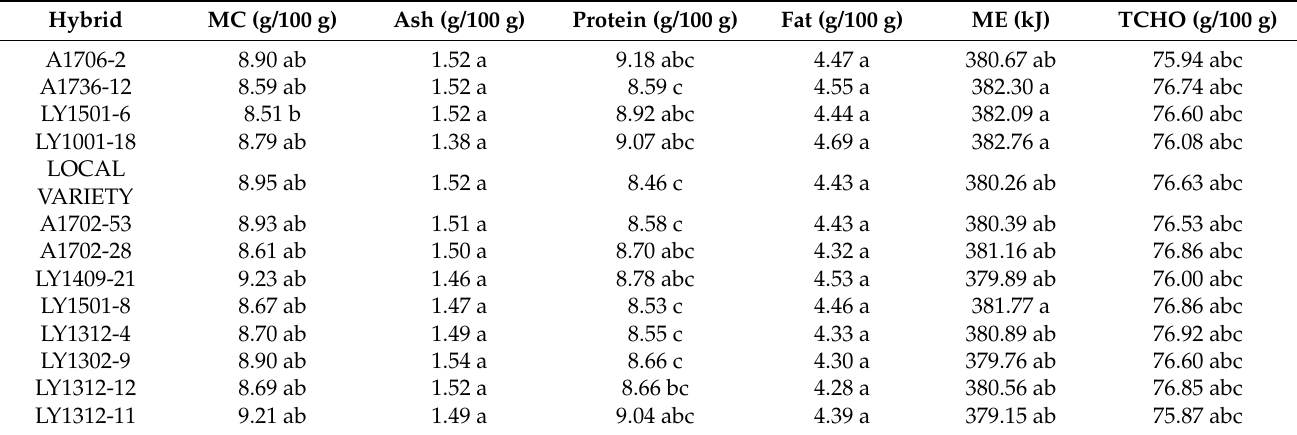
Table 1. Mean proximate composition of maize hybrids across different locations (N =